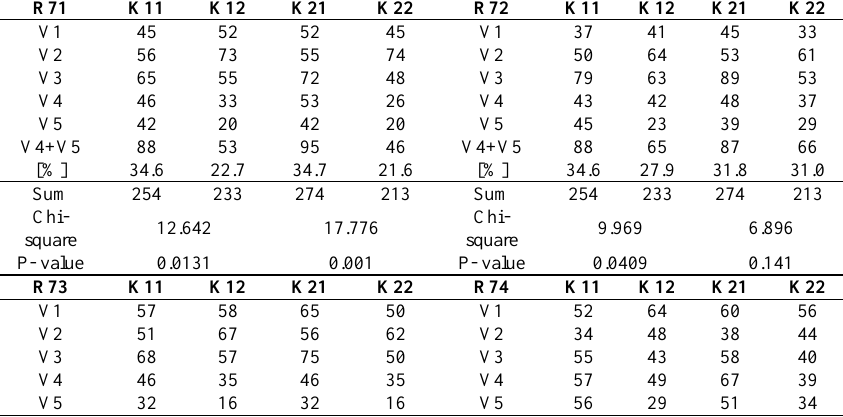
Table 7. The evaluation of sources of legal risk by